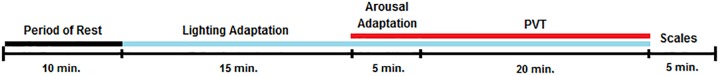
Overview of the experimental sessions. Black line: darkness; Blue line: lighting exposure; Red line: exercise-induced activation by pedaling; Scales: KSS (Karolinska Sleepiness Scale), PANAS (Positive and Negative Affect Schedule), RPE (Borg Rating of Perceived Exertion), and Mental Effort.